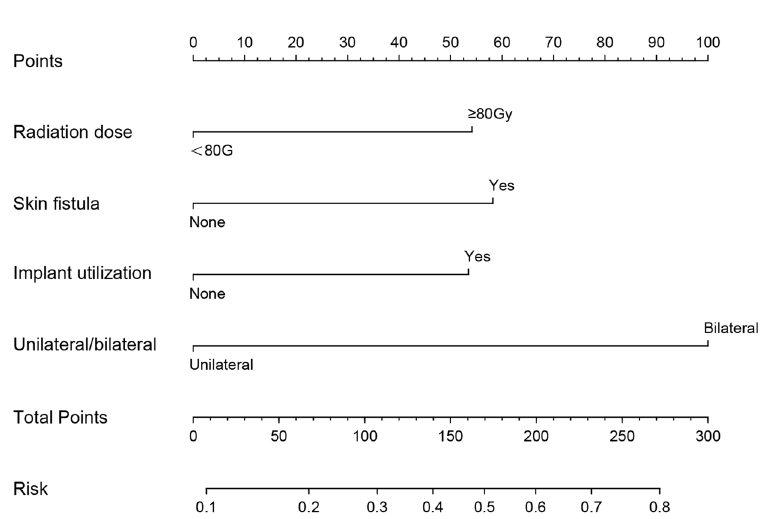
Figure 5. Nomogram model for predicting the risk of postoperative infection. Every patient was assigned a total point value and corresponding hazard risk can be calculated in the axis of